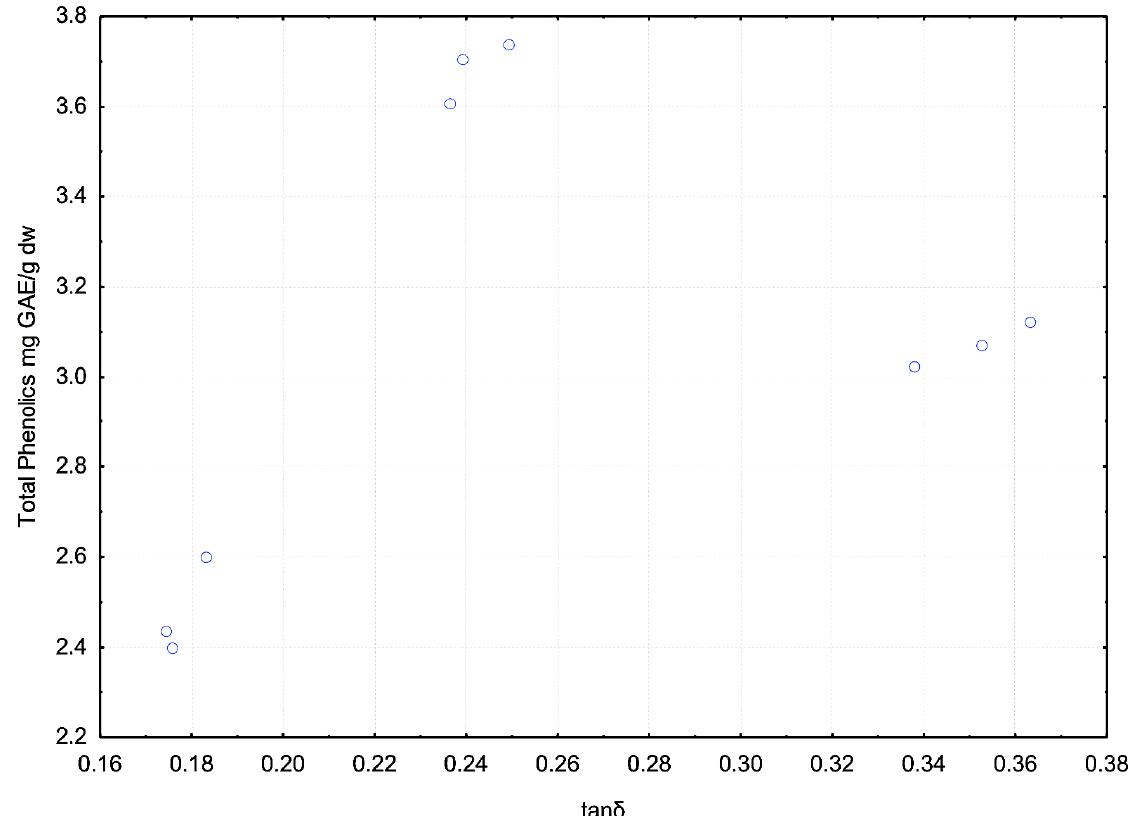
Figure 11. Effect of dissipation factor (tan δ ) on total phenolic yield after extraction for 5, 10 and 15 min during the MAE process (Source: Adapted from